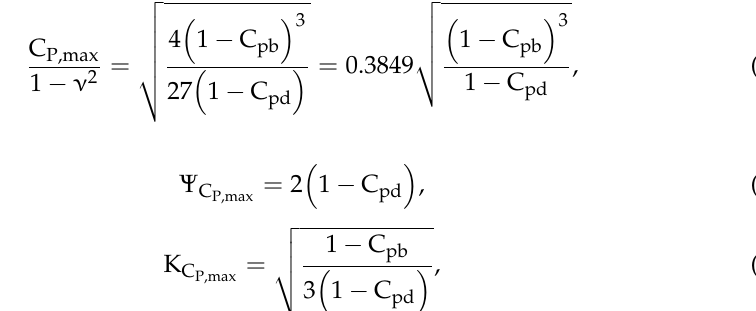
Figure 7. Variation of input power coefficient with loading coefficient.